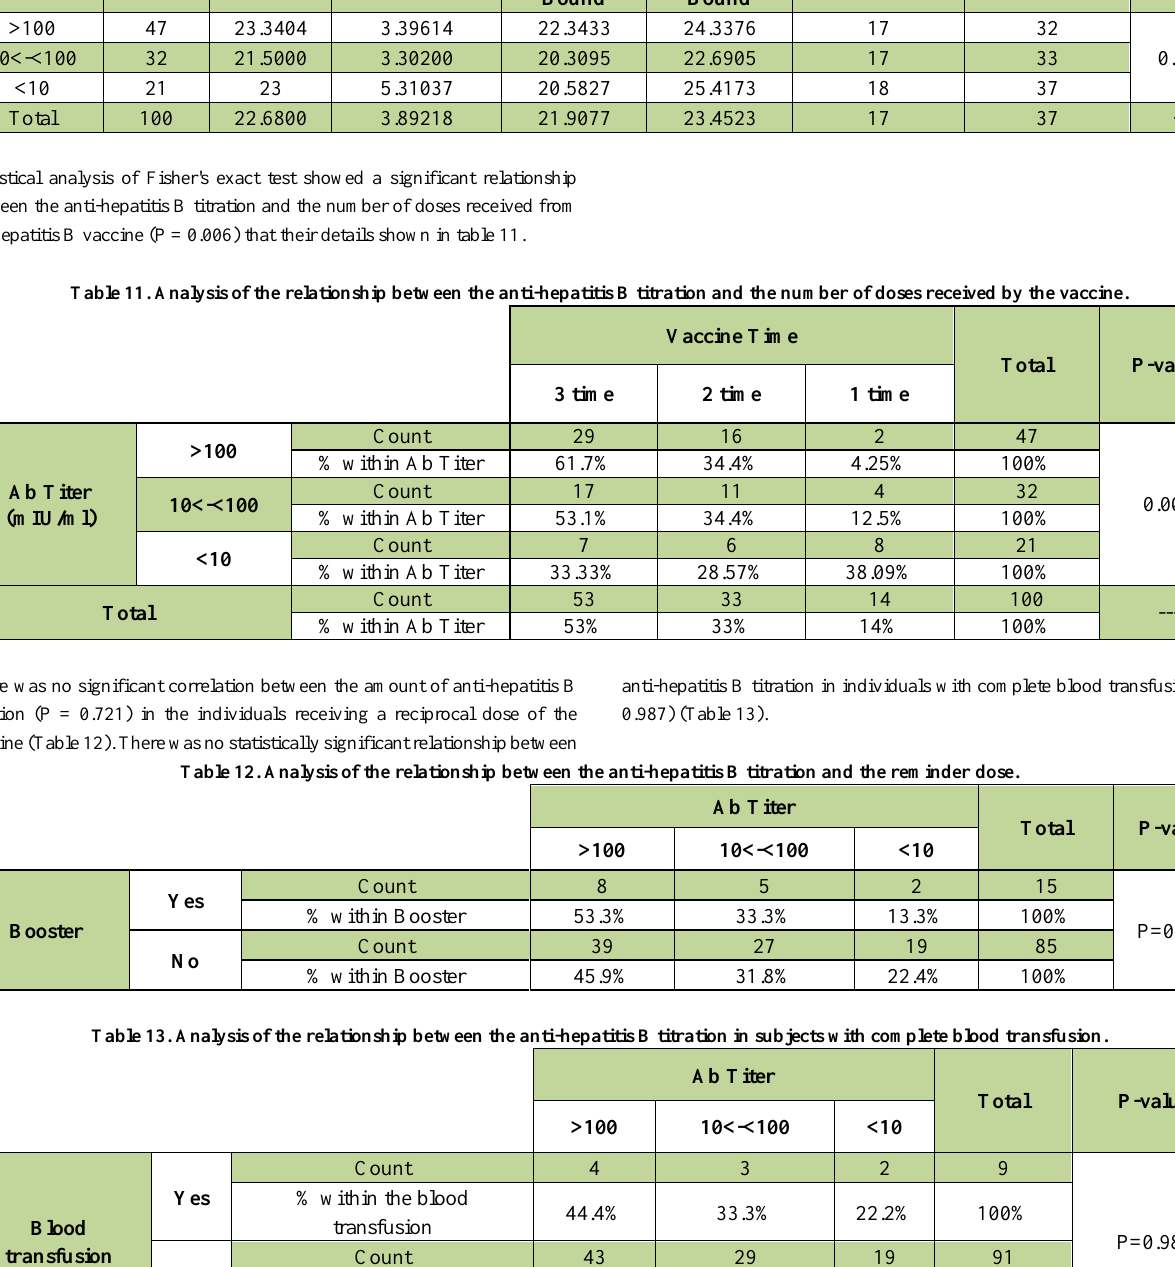
Table 10. Analysis of the relationship between the anti-hepatitis B titers in patients with their BMI. Ab Titer